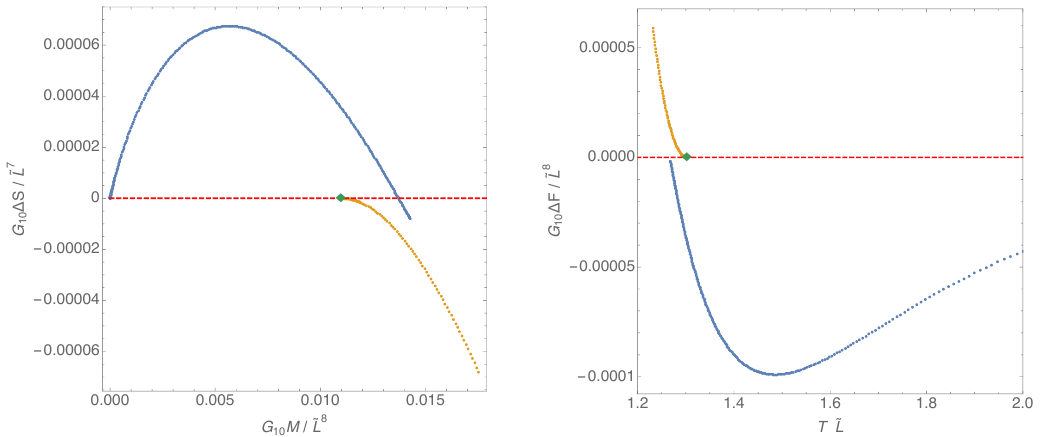
Figure 6 . Left panel: phase diagram of asymptotically R (1 ; 8) (cid:2) e S 1 vacuum Einstein solutions in the microcanonical ensemble. (cid:1) S gives the entropy di(cid:11)erence between a given solution and the uniform black string with the same energy E . Right panel: phase diagram of asymptotically R (1 ; 8) (cid:2) e S 1 vacuum Einstein solutions in the canonical ensemble. (cid:1) F gives the free energy di(cid:11)erence between a given solution and the uniform black string with the same temperature T . In these diagrams the horizontal (dashed red) line describes the uniform black string. The orange curve represents the nonuniform black string family and the blue curve describes the localised black hole